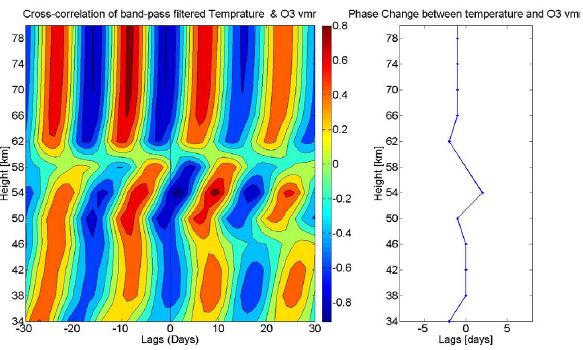
Figure 4. Left panel: The time ‐ lagged cross ‐ correlation between winter mesospheric temperature and Ozone at different levels. Red color represents correlation and blue denotes anti ‐ correlation. Right ‐ panel: vertical profile of phase change between temperature and O 3 vmr. These phases are all +/ ‐ 0.5 days.